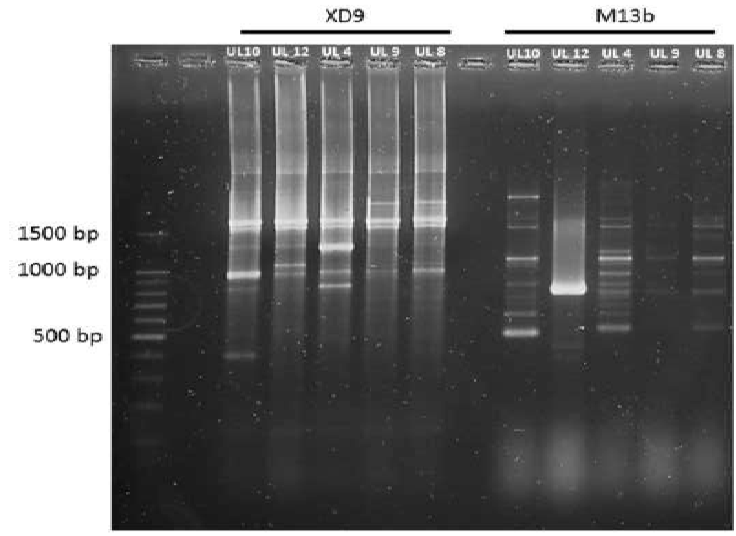
Figure 2. RAPD-PCR profiles obtained with XD9 and M13b primers representative of the selected LAB biotypes isolated from fermented goat sausages. M13b RAPD profiles: lane 1, Molecular weight